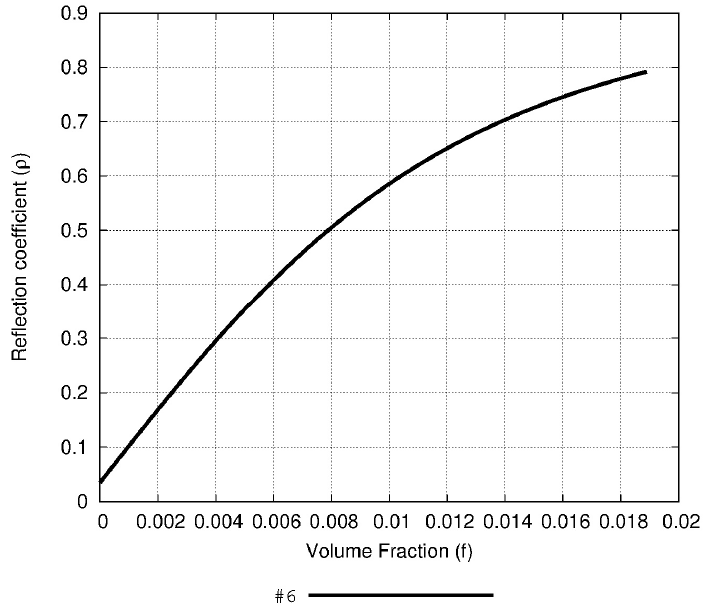
ε ; and a host medium with 1.00067 ε ; Figure 8. Volume fraction of a pollutant with ε i (cid:39) 3.2 and a host medium with ε e (cid:39) 1.00067 derived from Figure 8. Volume fraction of a pollutant with 3.2 i e the simulated reflection coe ffi cient of antenna 6 (Table 2). Assumptions related with the Bruggeman derived from the simulated reflection coefficient of antenna 6 (Table 2). Assumptions related with the formula have been done for the calculations. Bruggeman formula have been done for the calculations.